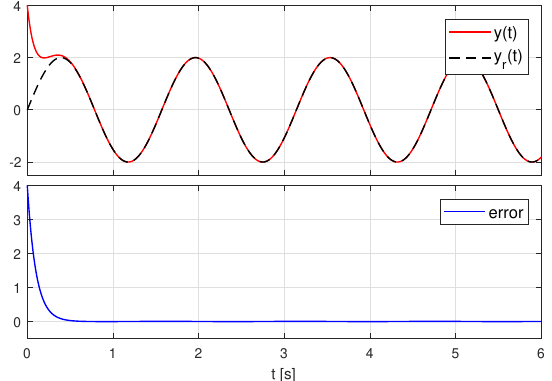
Figure 2. Performance of the regulator for λ = 0, i.e., to the case for which the R-D equation is reduced to the Fick’s second law of diffusion (also called simply as diffusion equation ), for whose case Γ 1 = 2.4674, Γ = 1, Γ = − 0.5, and Γ = 0. 2 3 4